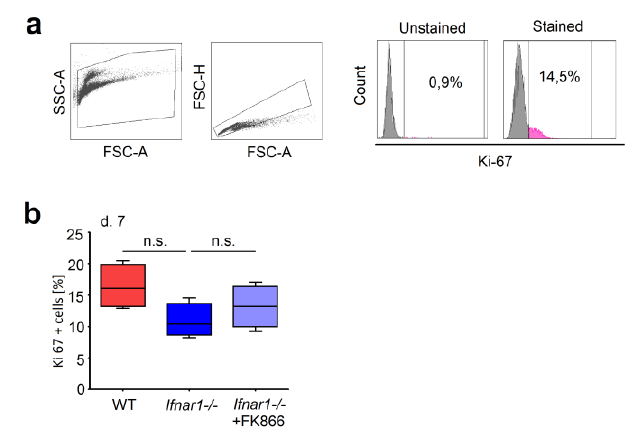
Figure A1. NAMPT inhibition did not influence proliferation of cells from WT and Ifnar1 -/- mice after in vitro maturation of progenitor cells from bone marrow. (a) Gating strategy for single KI-67 positive cells; (b) Proliferation of cells after 7 days in culture shows no differences between WT, Ifnar1 -/- and Ifnar1 -/- treated with FK866 cells. n = 4. Data are presented as median, 25th and 75th percentiles, and minimal and maximal values; n.s.—not significant.